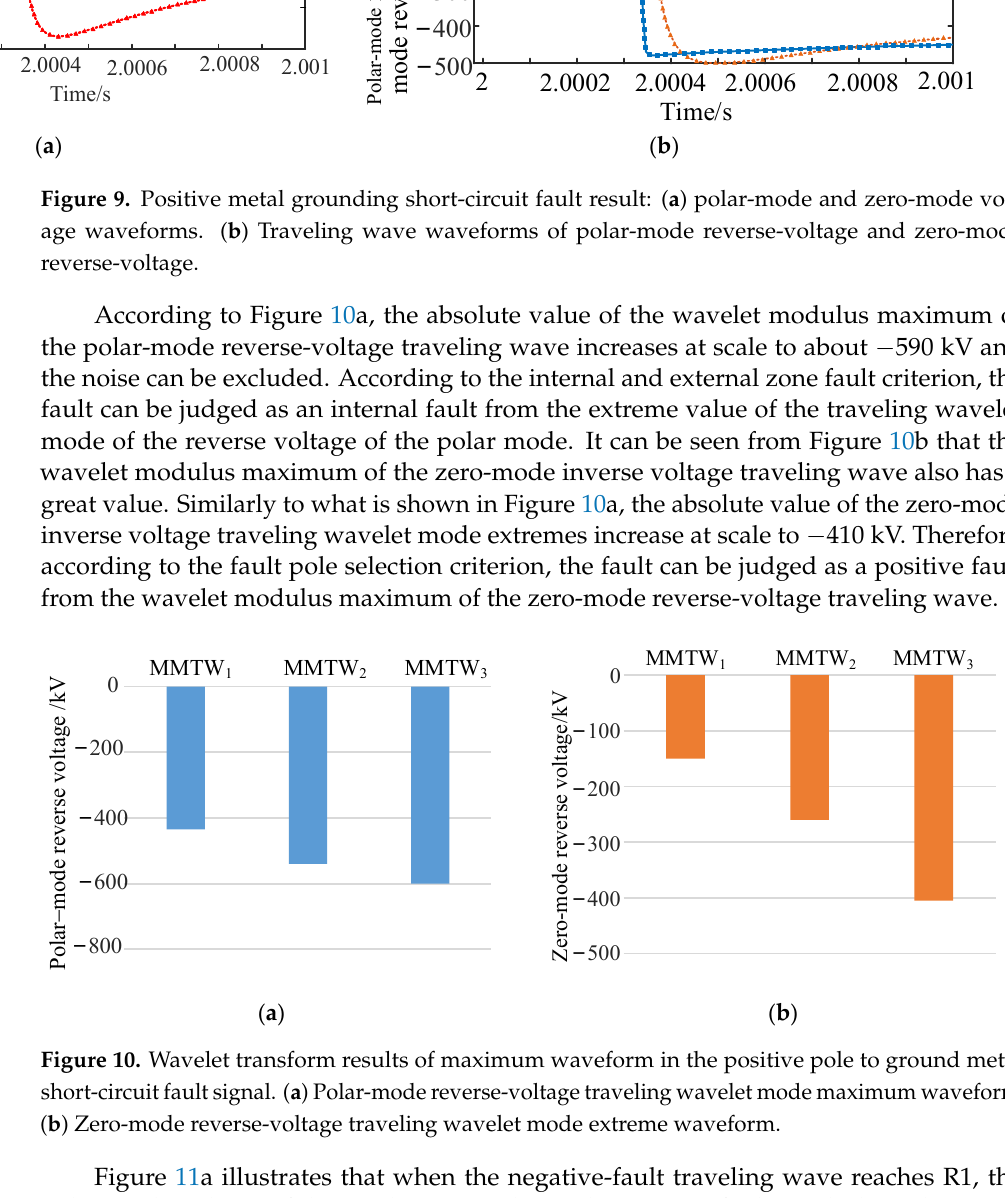
Polar-mode reverse voltage Zero - mode reverse voltage ( a ) ( b ) Figure 11. Negative metal grounding short ‐ circuit fault result: ( a ) polar ‐ mode and zero ‐ mode volt ‐ age waveforms. ( b ) Traveling wave waveforms of polar ‐ mode reverse and zero ‐ mode reverse volt ‐ age. Similarly, fault feature extraction is performed for the polar ‐ mode reverse ‐ voltage and zero ‐ mode reverse ‐ voltage traveling waves of the DC lines, and the wavelet modulus maxima at each scale are calculated. The calculation results are shown in Figure 12. The calculation result of the wavelet modulus maximum of the polar ‐ mode reverse ‐ voltage traveling wave is similar to that of the positive fault, and it can be determined as an